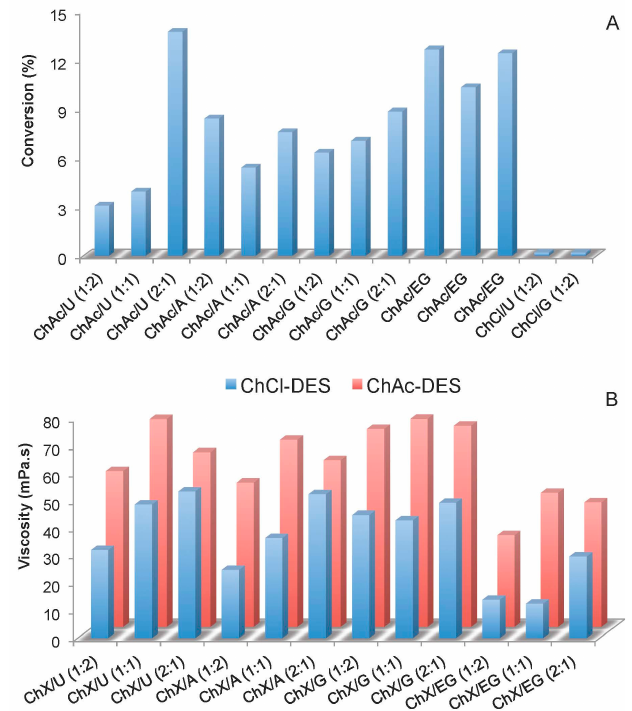
Figure 1. Conversions obtained in the DES/2M2B (1/9, v/v ) bisolvent system ( A ) and viscosities of DESs containing 10% water ( B ). For reaction conditions used in A, a reaction mixture containing 0.054 g of glucose (corresponding to 0.3 mole/L), 0.3 M of vinyl laurate, 100 mg of molecular sieves, and 20 mg of Lipozyme TLIM in 1-mL DES/2M2B (0.1/0.9, v/v ) was placed in an incubator/shaker with agitation of